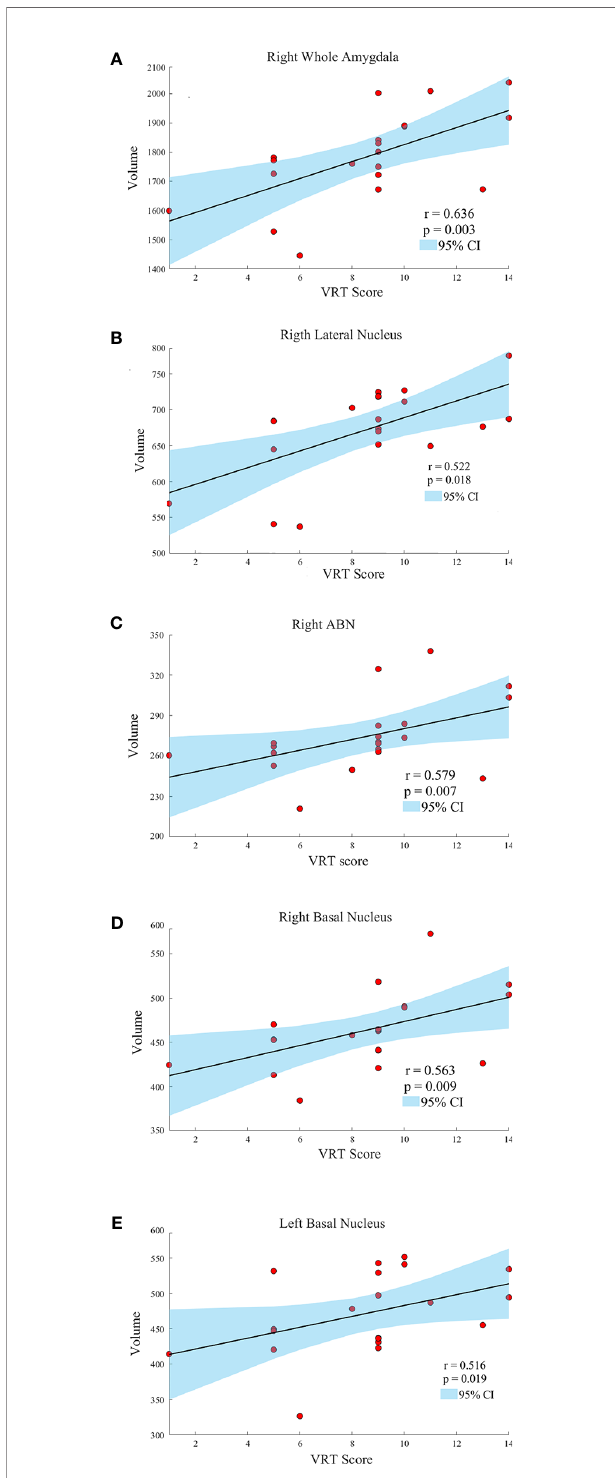
FIGURE 3 | Scatter plots showing the relationships between the amygdala and subnuclei volumes and VR I score in manic patients group ( A , Right Whole Amygdala; B , Right Lateral Nucleus; C , Right ABN; D , Right Basal Nucleus; E , Left Basal Nucleus). ABN, accessory basal nucleus; VR I, visual reproduction immediate recall